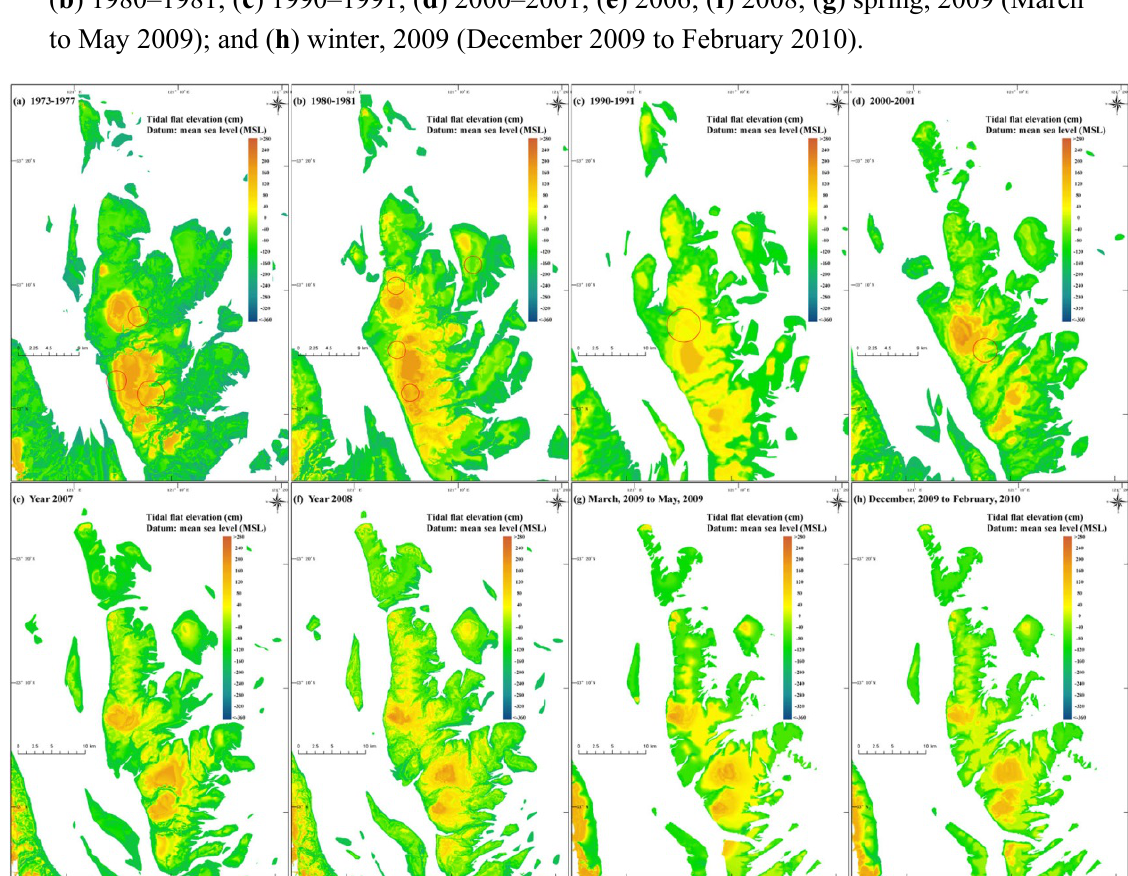
Figure 8. Tidal flat DEMs of the Dongsha Sandbank over different periods: ( a )